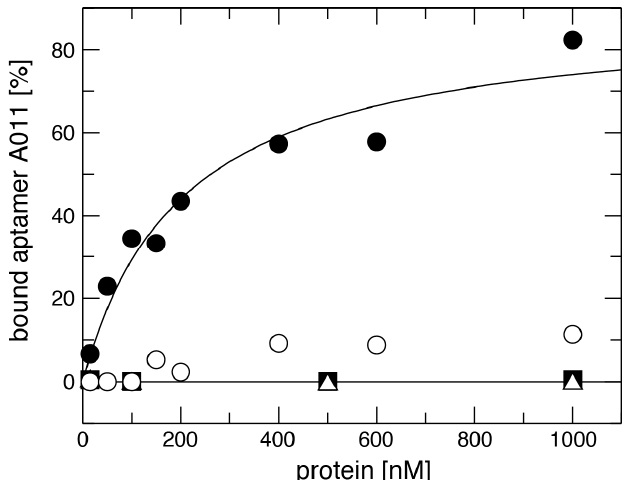
Figure 5. Example experiment illustrating binding of aptamer A011 binding to mLBP ( ● ), hLBP ( ○ ), EF-Tu ( ■ ) and BSA ( ∆ ), determined by NC filter binding assays in the presence of trace amounts of radiolabeled aptamer and increasing excess amounts of the respective protein. For experimental details, see Materials and Methods.